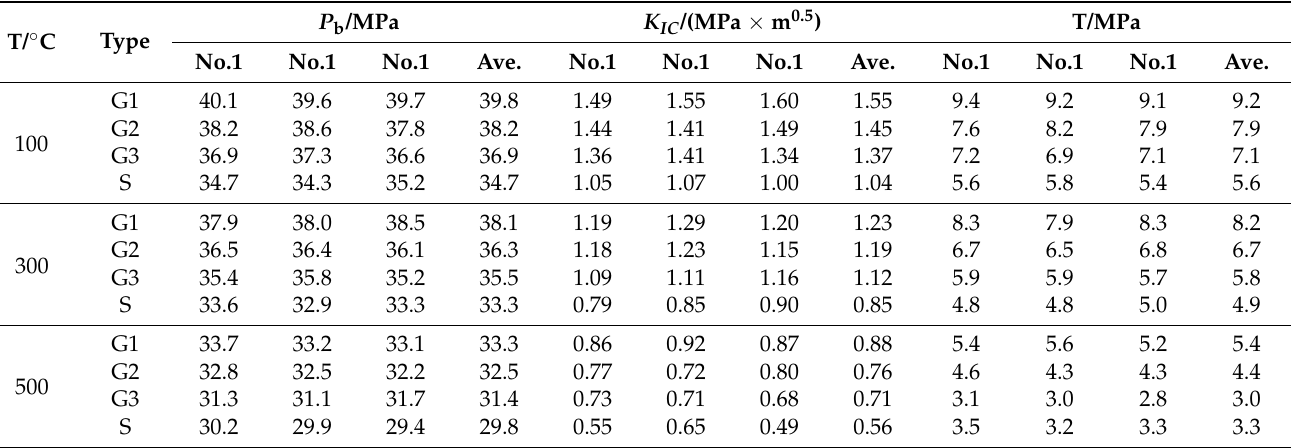
Table 1. Breakdown pressure, fracture toughness and tensile strength of specimens at various temperatures and lithologies.